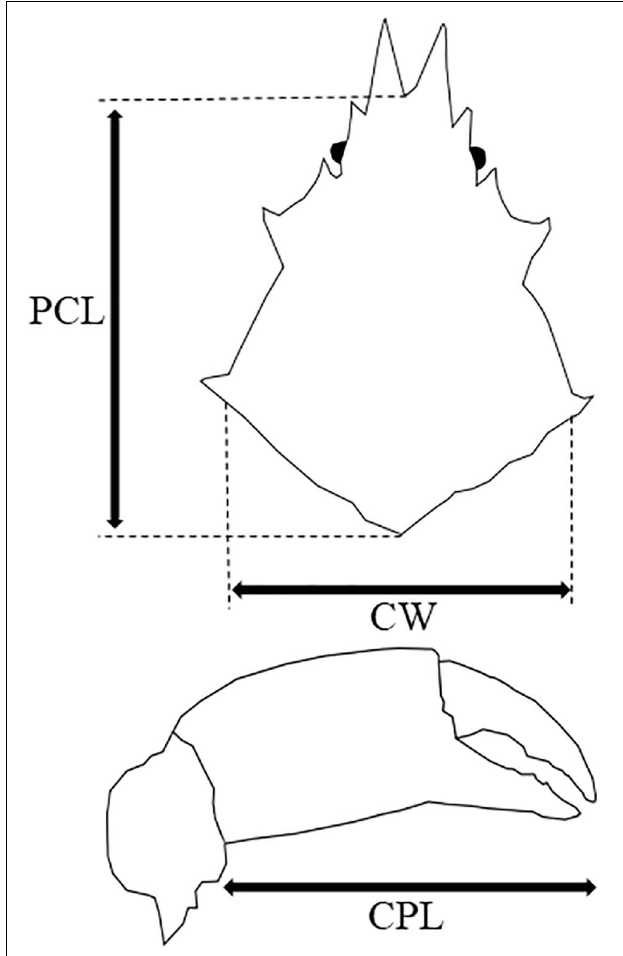
FIGURE 2 | Maximum carapace width (CW), post-pseudorostral carapace length (PCL), and cheliped propodus length (CPL) of P. ferox measured as body size